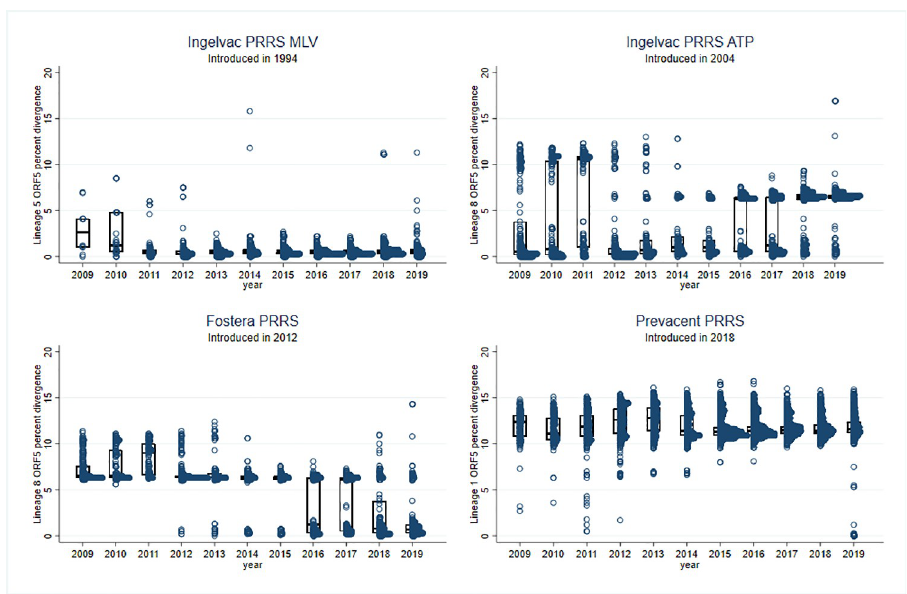
Fig 1. Yearly percent nucleotide differences between lineage 5 ORF5 sequences to Ingelvac PRRS MLV; lineage 8 sequences to either Ingelvac PRRS ATP or Fostera PRRS; and lineage 1 sequences to Prevacent PRRS.